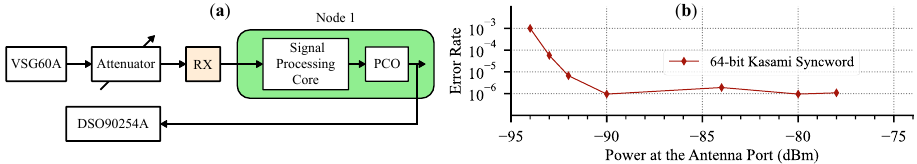
Figure 16. ( a ) Syncword error rate measurement setup. ( b ) Syncword detection error rate vs. signal strength at the antenna